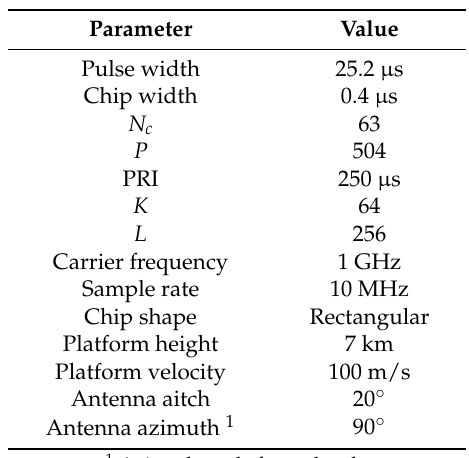
Table 1. Parameters for the transmit signal and the platform.